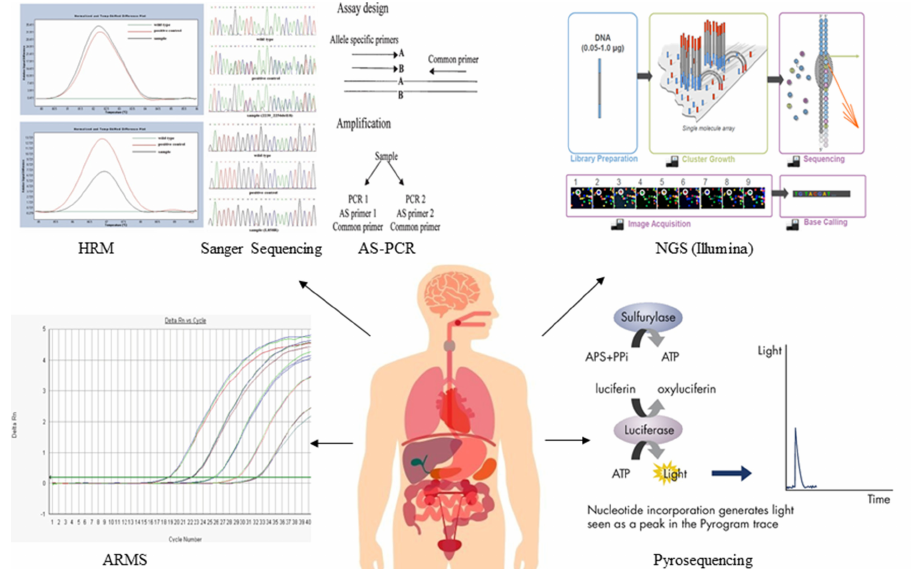
Figure 1. Mutation detection technologies. Images of HRM, Sanger sequencing, ARMS, and AS-PCR were adapted from (23, 24, 27)